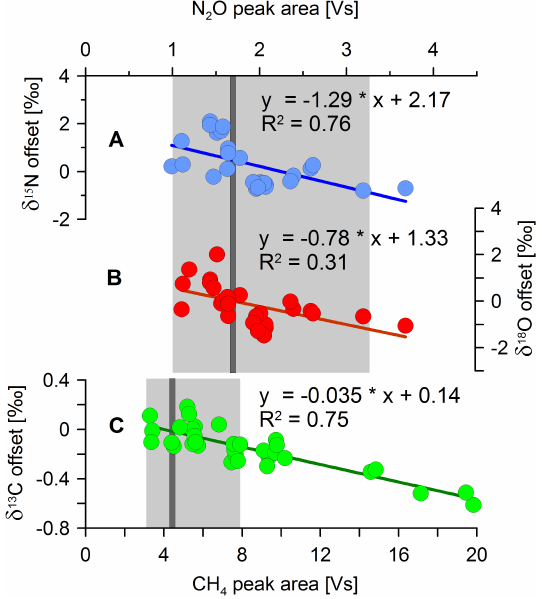
Fig. 6. Impact of sample size variability on the isotopic compo- sition of δ 15 N-N 2 O (A) , δ 18 O-N 2 O (B) and δ 13 C-CH 4 (C) . The offsets in isotopic composition of CH 4 and N 2 O were determined in 33 and 26BFI extractions, respectively. The dark-grey lines indi- cate the IRMS peak area of the reference gas measurements (GIS), which were used to reference the BFI samples to the respective iso- tope scales. The shaded zones indicate the IRMS peak area range of ice core sample measurements. Coloured lines display the lin- ear regressions that are used to correct the isotopic composition of sample measurements for the difference in IRMS peak area between sample and reference